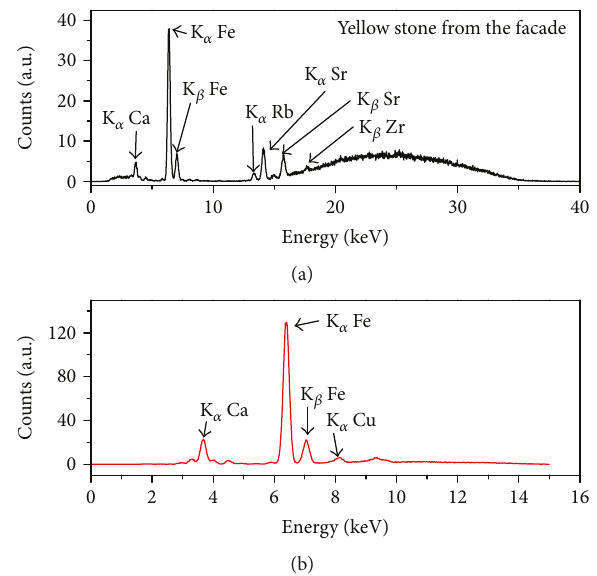
Figure 15: XRF spectra, in the 0 – 40keV range (a) and 0 – 16keV range (b), of a yellow stone from the facade of the Abbey of SS. Pietro e Paolo d ’